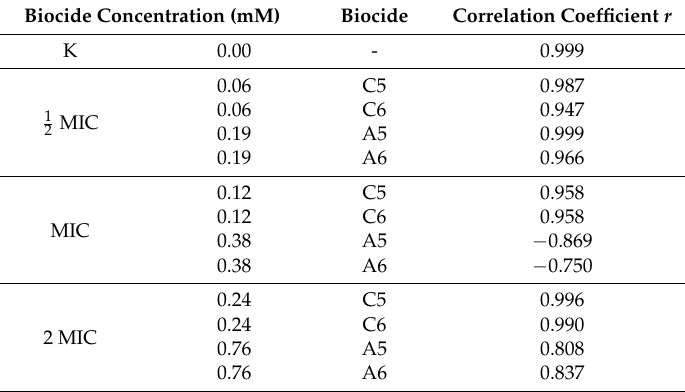
Table 3. Pearson’s correlation coefficient ( r ) for ergosterol concentration and mycelial dry weight content. Biocide Concentration (mM)